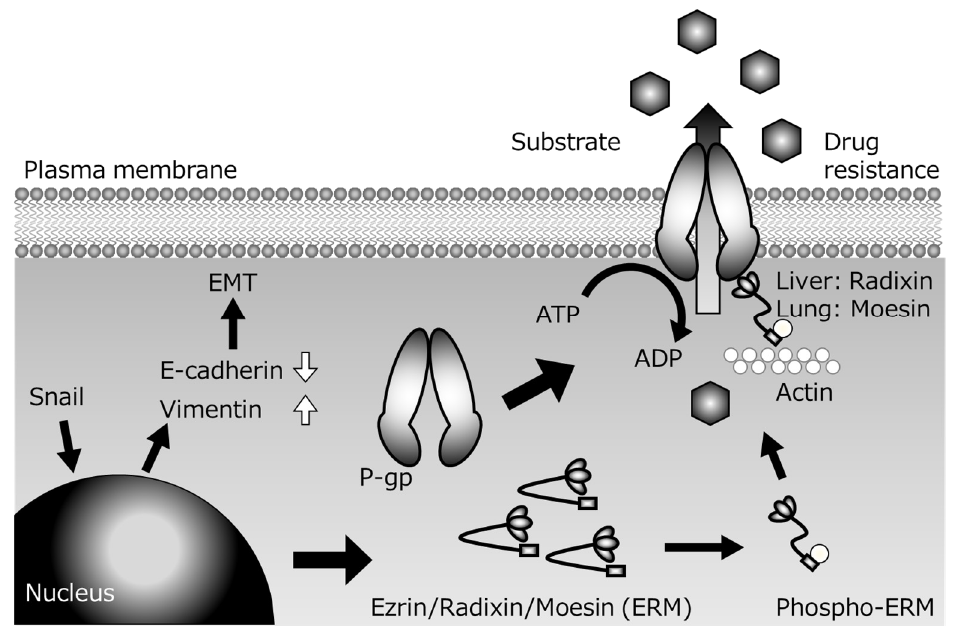
Figure 2. Presumed mechanisms of P-glycoprotein (P-gp)-mediated drug resistance during Snail-induce epithelial–mesenchymal transition (EMT).